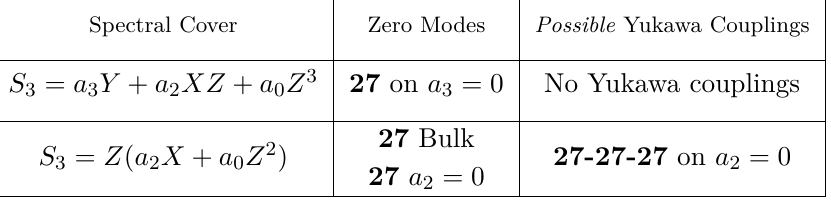
Table 1 . E 6 models Yukawa